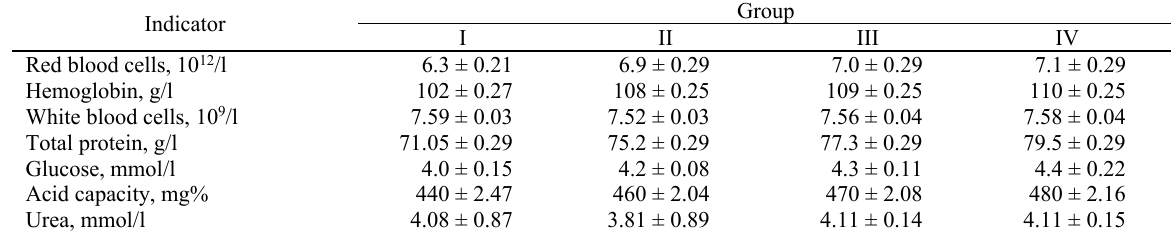
Blood mineral composition